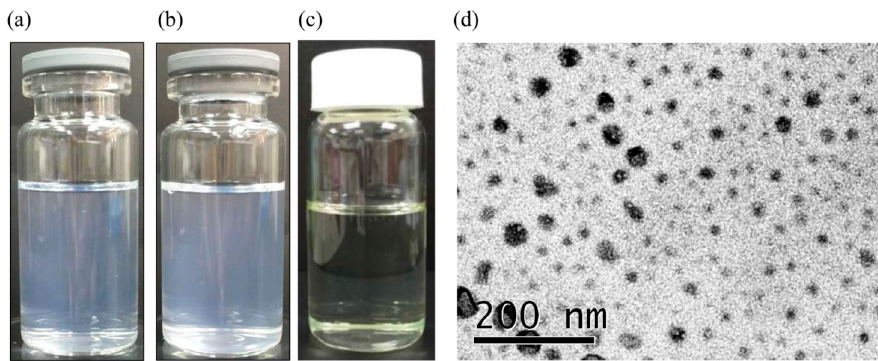
Figure 2. Resveratrol self-nanoemulsifying drug delivery system (RES-SNEDDS) dispersed in: ( a ) water; and ( b ) 0.1 N HCl; ( c ) the appearance of F7 RES-SNEDDS; and ( d ) transmission electron micrograph of F7 RES-SNEDDS.